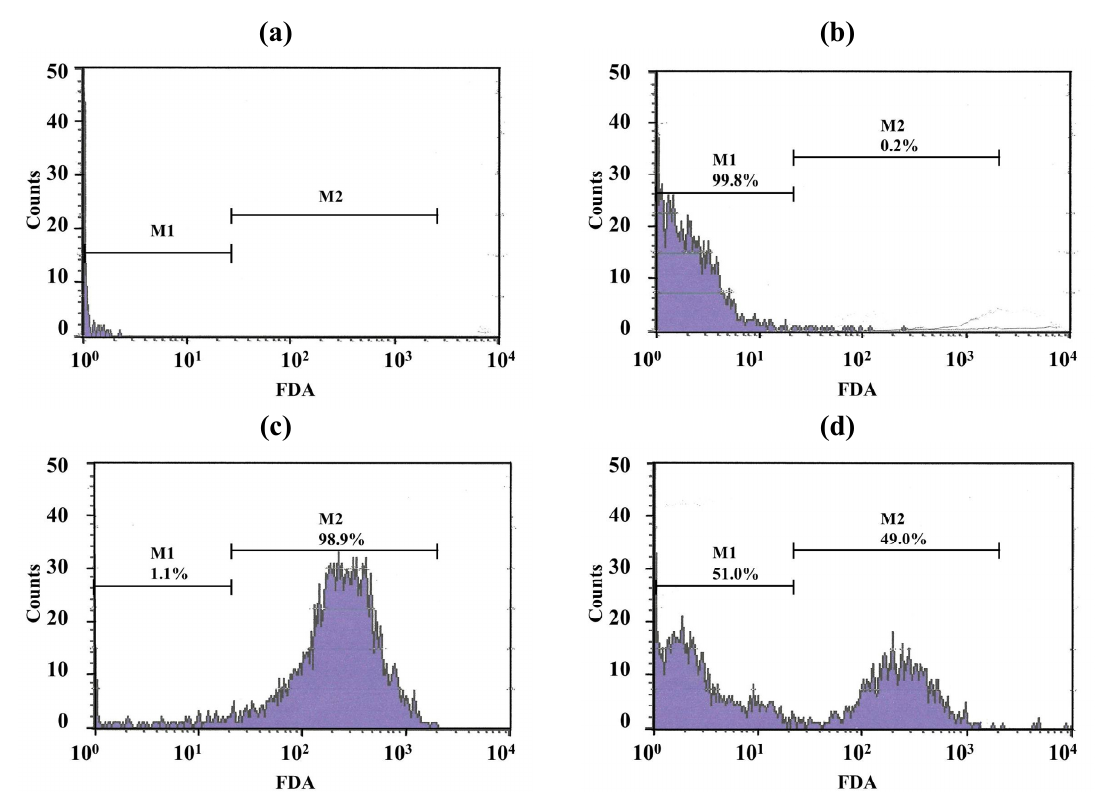
Figure 7. Histograms with histogram markers M1 and M2 of ( a ) M7H9 medium; ( b ) unstained viable M. bovis ; ( c ) viable M. bovis stained with fluorescein diacetate; ( d ) viable M. bovis incubated with LEV-proliposome formulation No. 1 at 0.25 μ g/mL for 5 days and then stained with fluorescein diacetate (FDA).